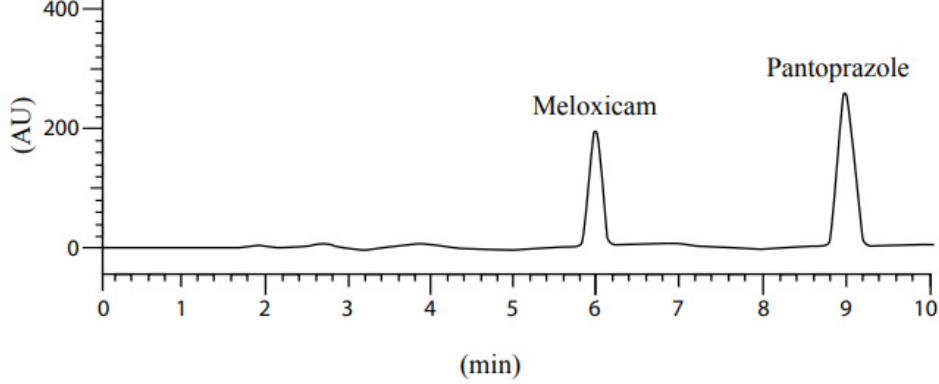
13 Table 3. System parameters for simultaneous measurements of diluent-containing meloxicam and pantoprazole . Parameters